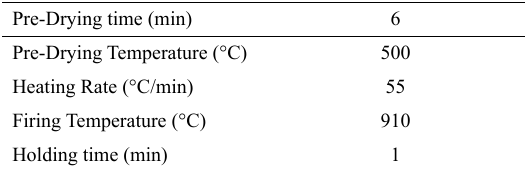
Table 1. Firing schedule for Vita VM9 Dentine porcelain Pre-Drying time